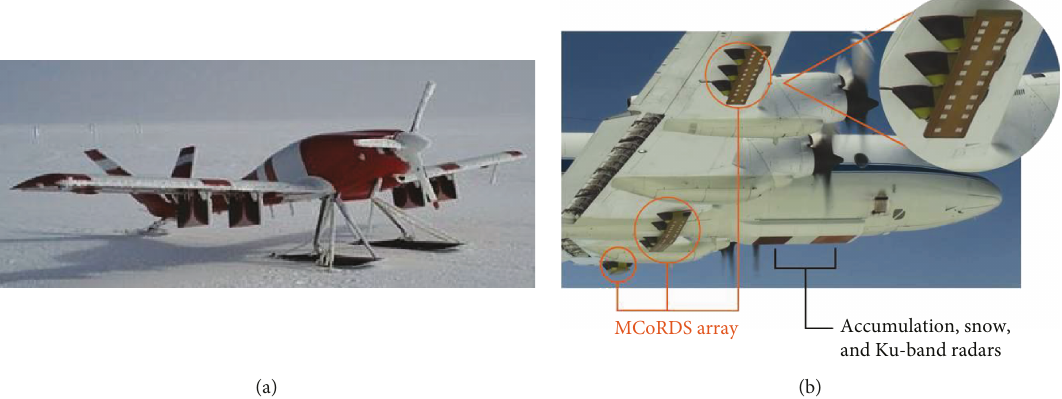
Figure 1: Meridian UAS with four Vivaldi antennas integrated below wing [16] (a) and NASA P-3 with all sensors installed [9]